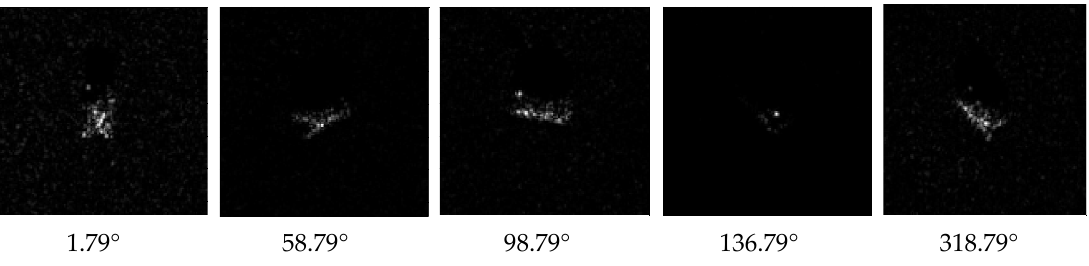
Figure 1. Description of aspect angle and depression angle in microwave imaging radar sensor.